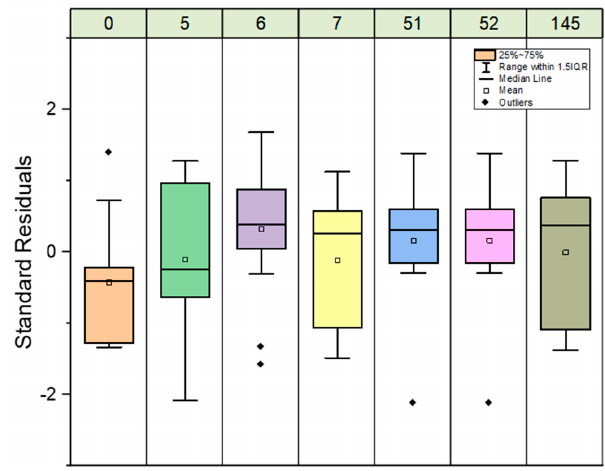
Figure 3. Standard residual box-whisker plots for Sr-90 reference solutions (5 to 40 pg / g) in function of time between 0 and 145 days .